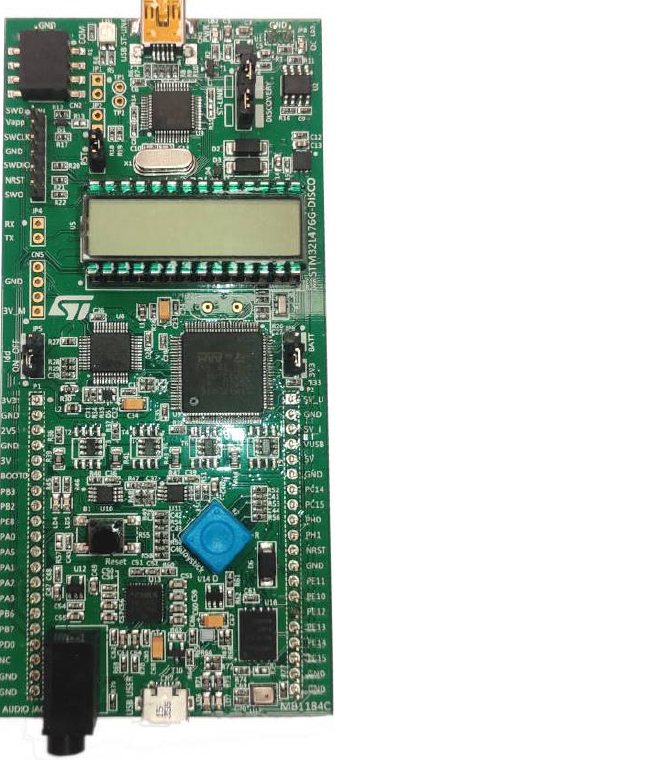
Figure 4. Photograph of the 32L476GDISCOVERY development